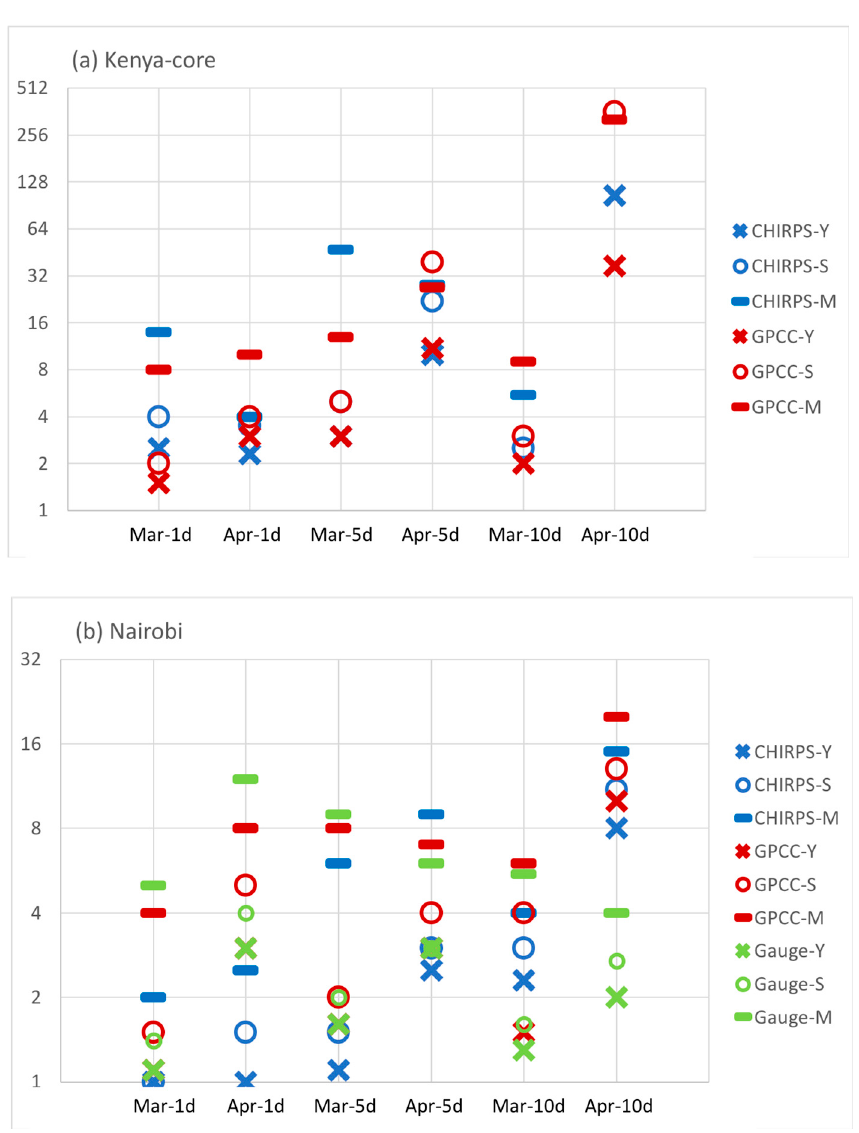
Figure 4. Time series of daily rainfall from CHIRPS (green) and GPCC (blue) averaged over the Kenya-core region and from the area averaged Nairobi gauges (red). The periods of intra-seasonal enhanced rainfall P1–P3 are indicated, in which P1 represents 28 February–6 March, P2 represents 12–19 March, and P3 represents 13–23 April.